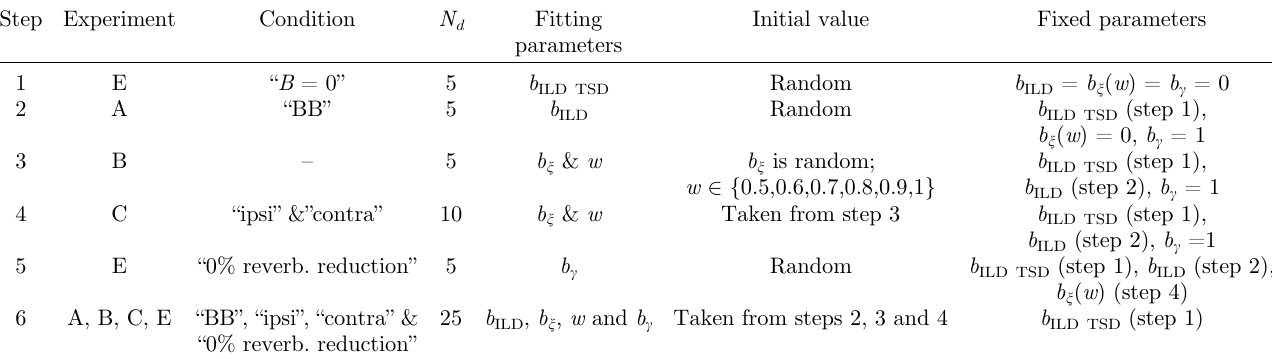
Table 2. The iterative steps of model fi tting for each subject. N d represents the number of data points per subject. Model variables and parameters are explained in Section 2. The results of obtained weighting factors are listed in Table